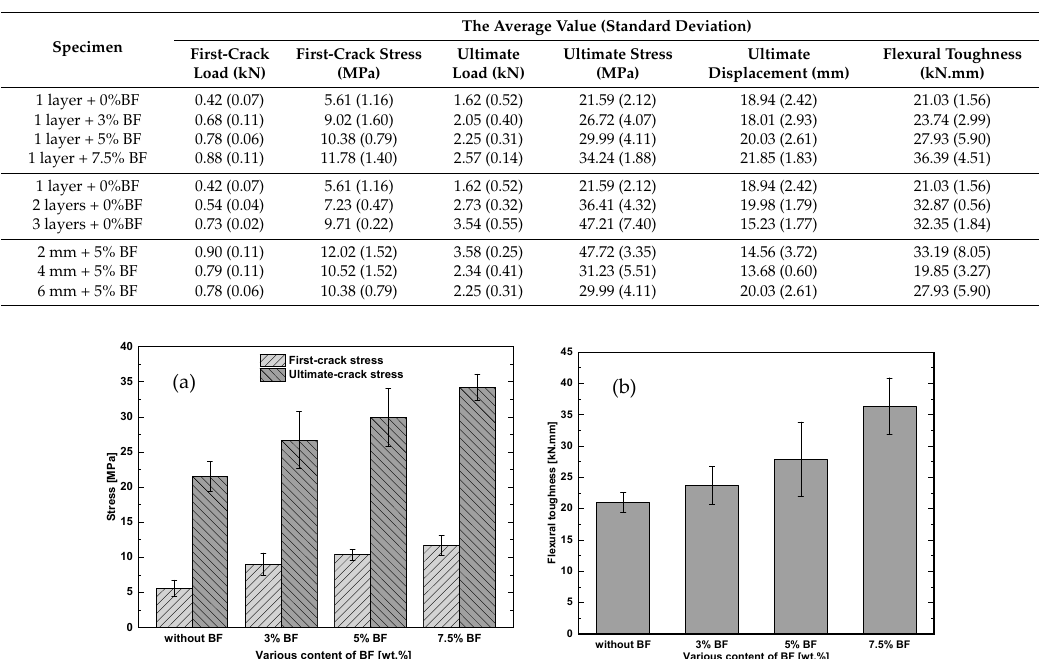
Table 3. Results of the flexural behavior of the thin plate specimens with respect to the different percentage contents of the BF, the number of textile layers, and the thicknesses of the mortar cover layer.